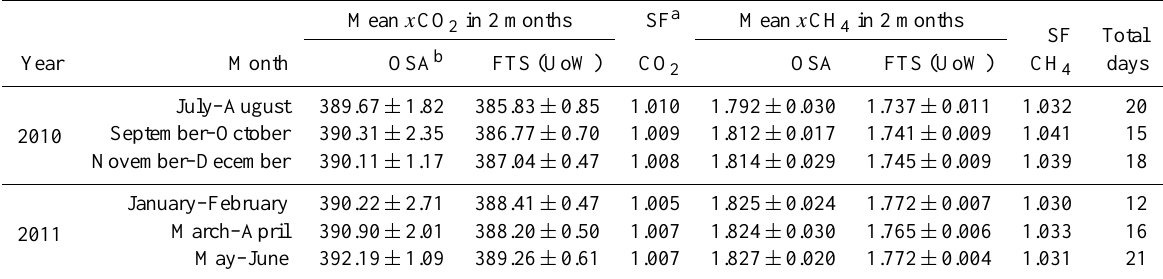
Table 2. Scale factors for x CO 2 and x CH 4 from the OSA.